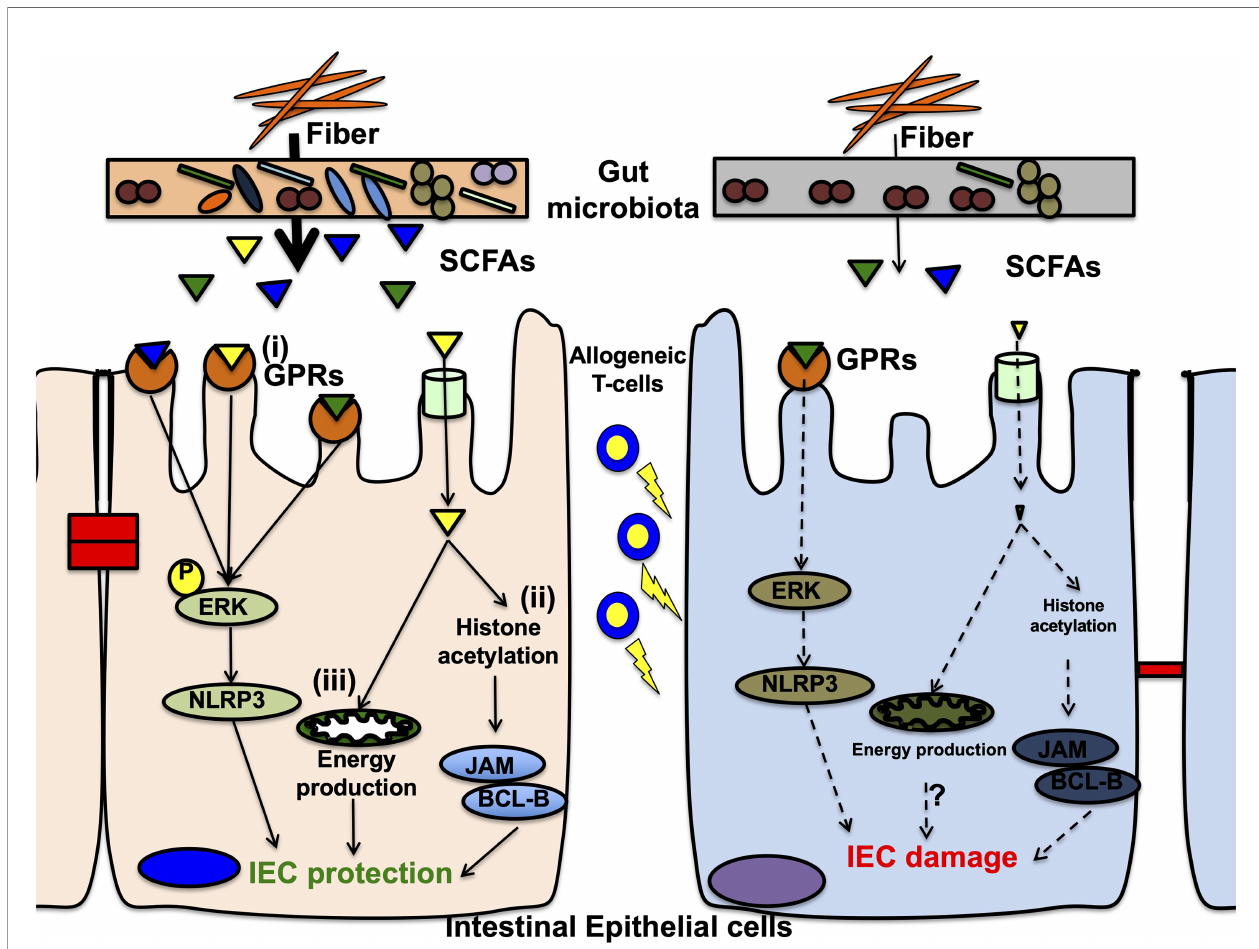
FIGURE 2 | Mechanisms of short chain fatty acids on intestinal epithelial cells in the pathophysiology of gastrointestinal GVHD. In the normal condition, short chain fatty acids (SCFAs) that are metabolites from microbial fermentation of dietary fi bers, protect intestinal epithelial cells (IECs) in at least 3ways. (i) G-protein-coupled receptors (GPRs) on IECs, especially GPR43, sensor SCFAs and signal ERK phosphorylation leading to subsequent NLRP3 in fl ammasome activation, that promotes IEC integrity. In graft- versus -host disease (GVHD), decreases of GPRs on IECs and reduced SCFAs from dysbiosis diminish intracellular signaling via ERK-NLRP3 pathway, resulting in IEC damages. (ii) One of SCFAs, butyrate acts as a histone deacetylase inhibitor, and increases various target gene expressions, including anti- apoptotic BCL-B and the junctional protein JAM (junctional adhesion molecule). These gene expressions result in decreased IEC apoptosis and enhanced junctional integrity, leading to IEC protection. In GVHD, reduced butyrate fails to protect histones from deacetylation and decreased target gene expression, resulting in low resistance against allogeneic T-cell injuries. (iii) Butyrate activates peroxisome proliferator-activated receptor- g (PPAR- g ) signaling in IECs and promotes mitochondrial ß-oxidation that produce enough amount of energy to protect and maintain IECs from cellular damages. In GVHD, reduced butyrate might not activate PPAR- g , resulting in mitochondrial dysfunction for energy production that are inappropriate for IEC protection against allogeneic T-cell injuries. This mechanism is studied in in fl ammatory bowel disease but not validated in GVHD. Further investigations are